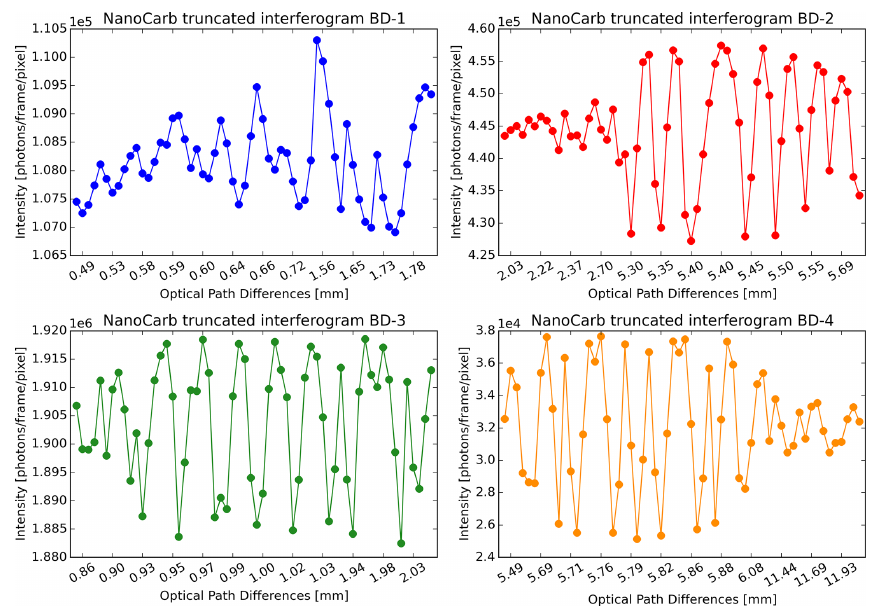
Figure 2. Example of a NanoCarb truncated interferogram for the four spectral bands (denoted BD in the figure), for a central pixel of the field of view, simulated for the same situation as for Fig. 1. Intensities are plotted as a function of the OPD indices as the OPD sampling is very